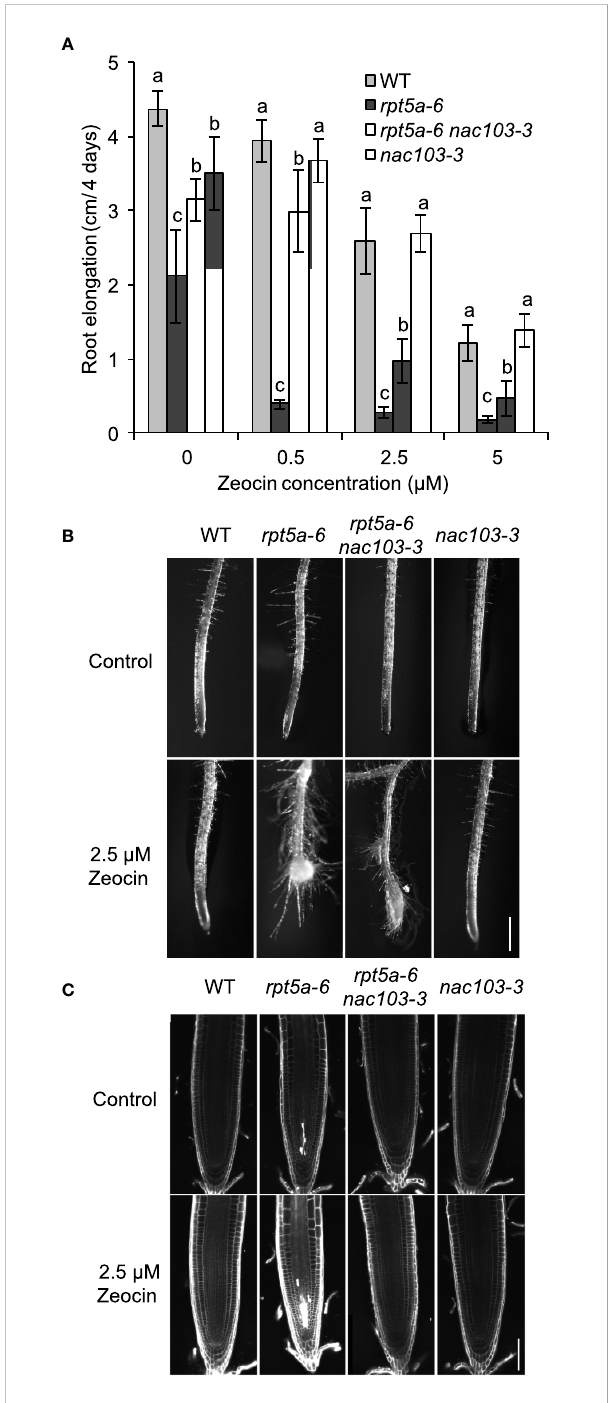
FIGURE 6 DNA damage sensitivity of rpt5a-6 is suppressed in rpt5a-6 nac103- 3. Sensitivity to DNA damage causing regent Zeocin. (A) Root elongation under various Zeocin concentrations. Seedlings were precultured the control condition for six days and for further four days with or without Zeocin. Primary root elongation during last four days were measured. Values represent mean ± standard deviation of ten seedlings. For each condition, groups sharing same letters were not signi fi cantly different by Tukey-Kramer ’ s test at p < 0.05. (B) Primary root tip morphology of 11-day-old seedlings under control or 2.5 µM Zeocin conditions. Bar, 500 µm. (C) Confocal microscopy of root meristems. Six-day-old seedlings grown under the control condition were treated with control or 2.5 µM Zeocin conditions for 16 hours. Cell walls and dead cells were visualized with propidium iodide. Bar, 50